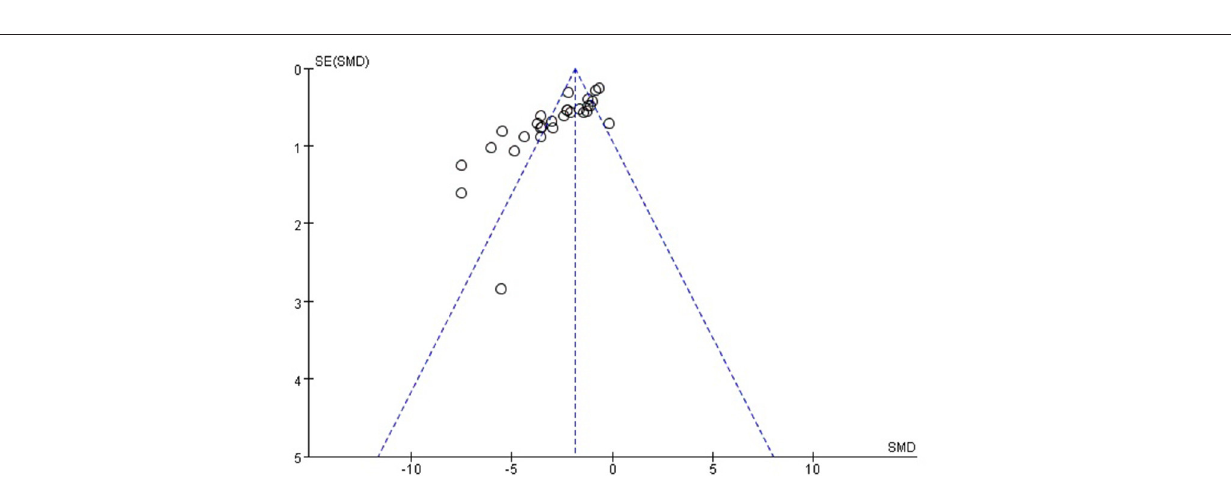
research (Kalaria et al., 2008). However, there are several model methods for inducing these two dementia types and their differences of effectiveness and robustness are not